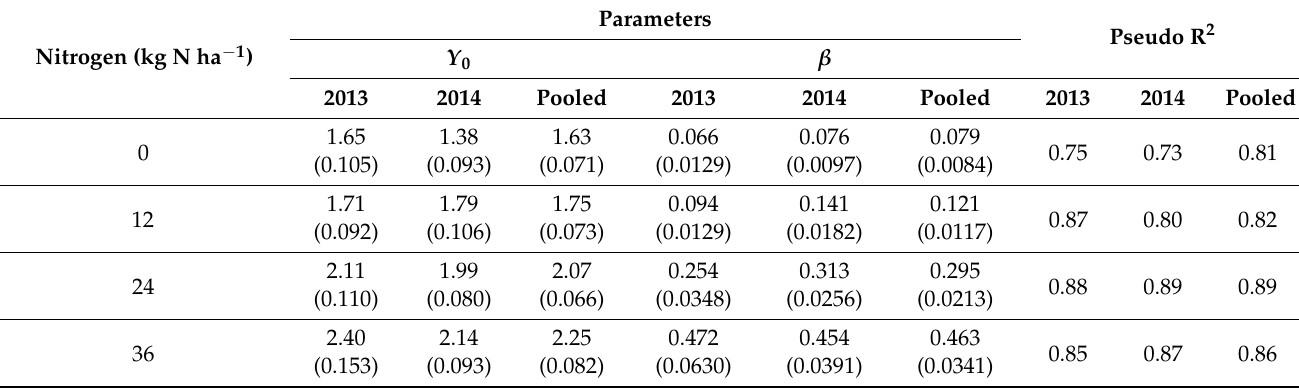
Figure 1. Soybean yield as a function of the total density equivalent at different nitrogen levels in 2013 (···) and 2014 (---) and for the pooled two-year (—) data. The lines are fitted values calculated using the rectangular hyperbolic model and parameter estimates (Table 3). Table 3. Parameter estimates for the rectangular hyperbolic model for the regression of soybean yield as a result of multiple weed interference expressed as the total density equivalent at different nitrogen levels in 2013 and 2014 and for the pooled two-year data. The numbers in parentheses are the standard